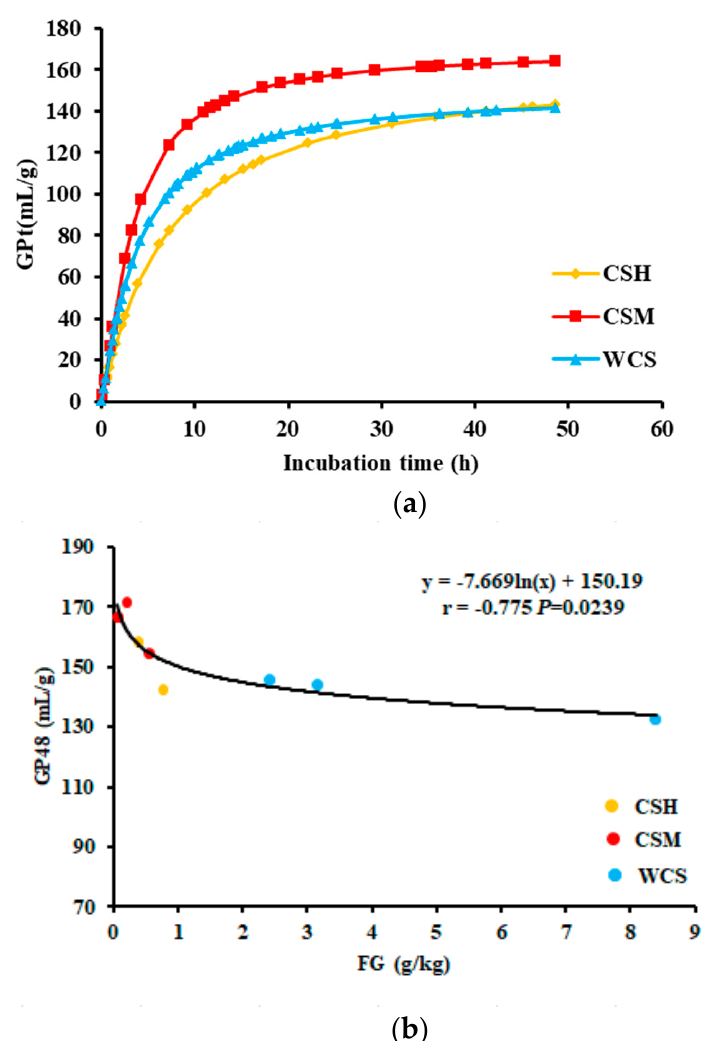
Figure 2. ( a ) Gas production curve of cottonseed and its by-products. ( b ) Correlation analysis of the free gossypol content and gas production. GP, gas production; FG, free gossypol. Table 3. Gas production kinetic parameters of cottonseed and its by-products.